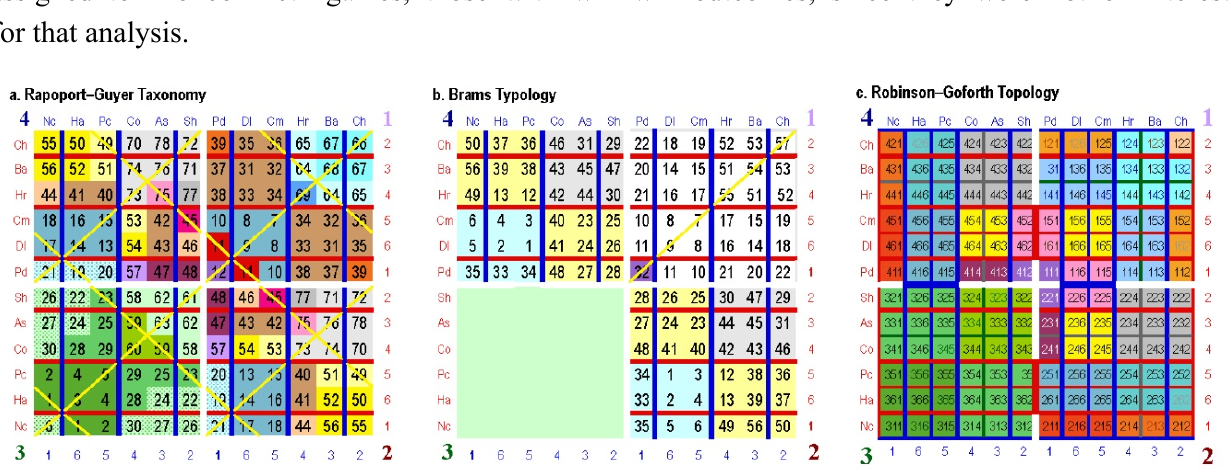
Figure 4. Three schemes for numbering strict ordinal